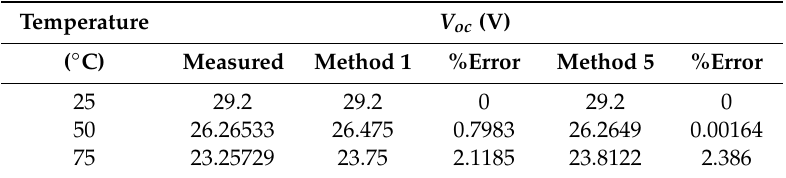
Table 10. Calculated and measured V oc (V), and relative error of the KC175GT module under di ff erent temperatures and an irradiance of 1000 W / m 2 .